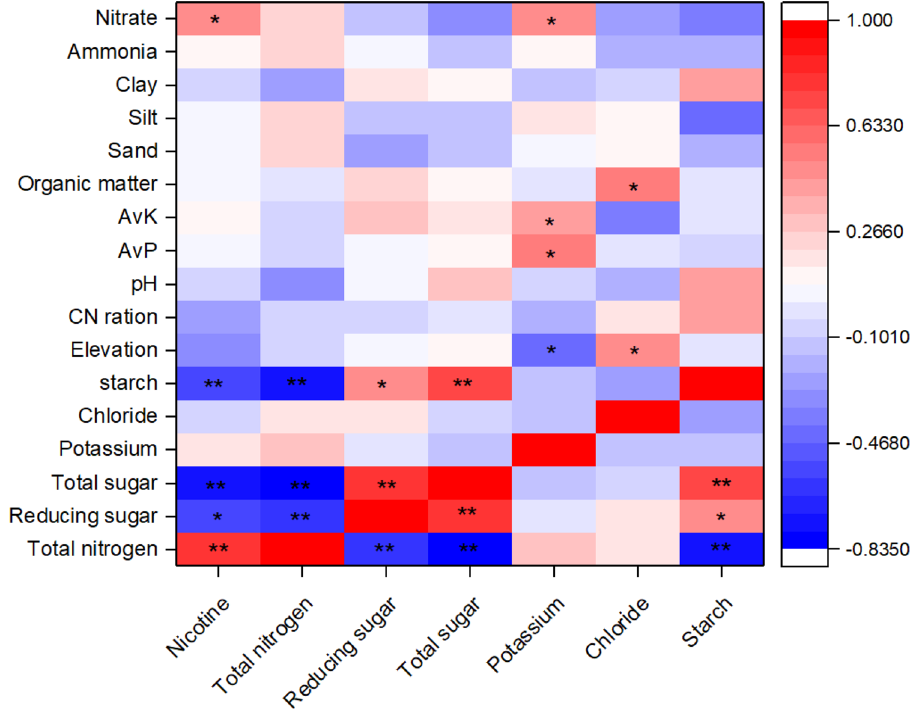
Figure 2. Heat map basing on Pearson correlation coefficients among chemical constituents of the tobacco leaves (n = 20). AvK available potassium, AvP available phosphorous, CN ratio ratio of total carbon and nitrogen concentrations in